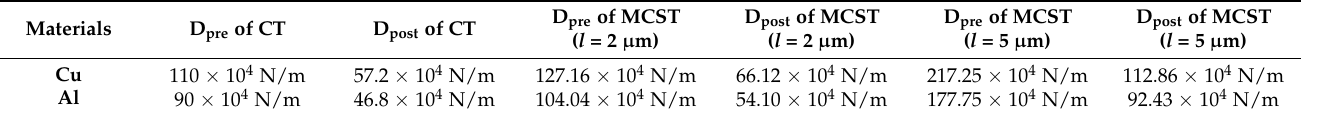
Figure 3. Pre-buckling and linear post-buckling responses of thin Cu plate based on CT and MCST.